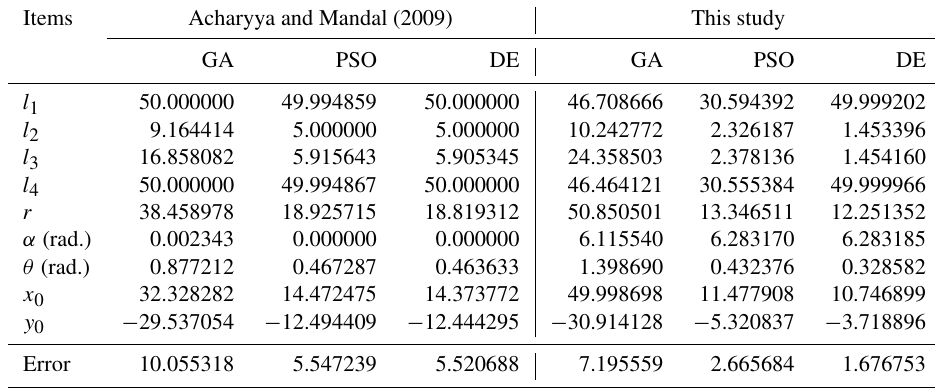
Table 2. Linkage solutions and structural errors obtained in previous work and in this study for Example 2. Items